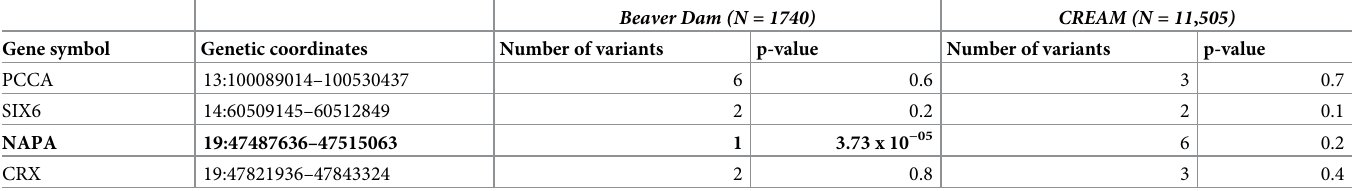
Table 3. Replication of four loci associated with refractive error using gene-based analyses performed in Beaver Dam (N = 1740) and CREAM Consortium dataset (N = 11,505).